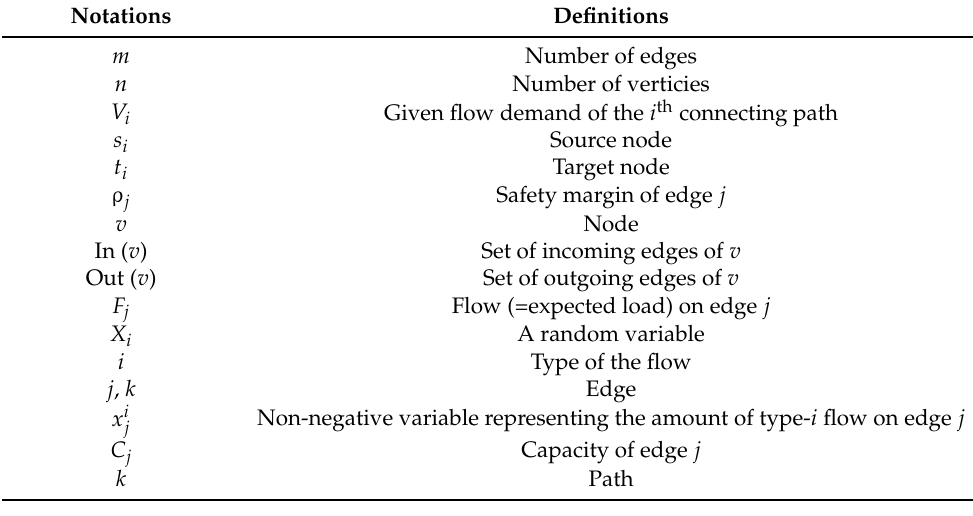
Table 1. Notations and